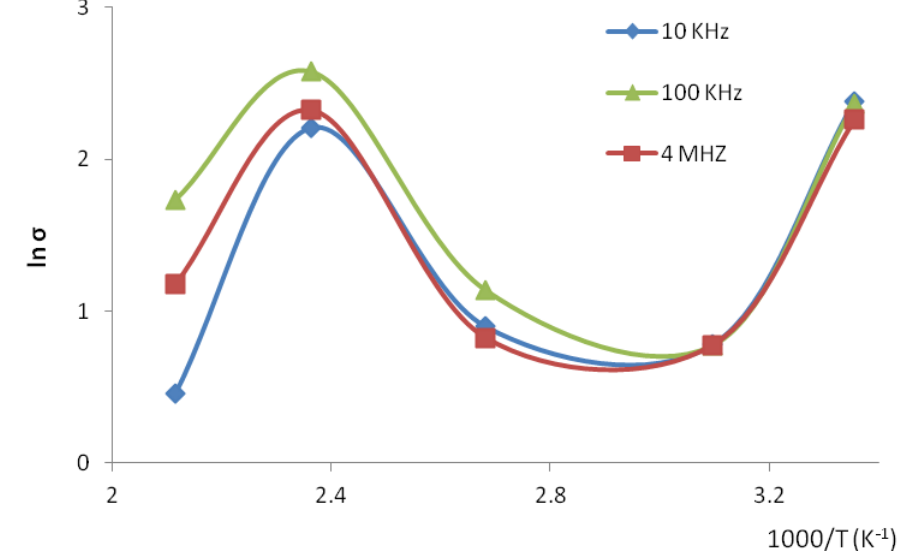
Fig. 8 The variation of ln σ with 1000/T for pure ZnS films.